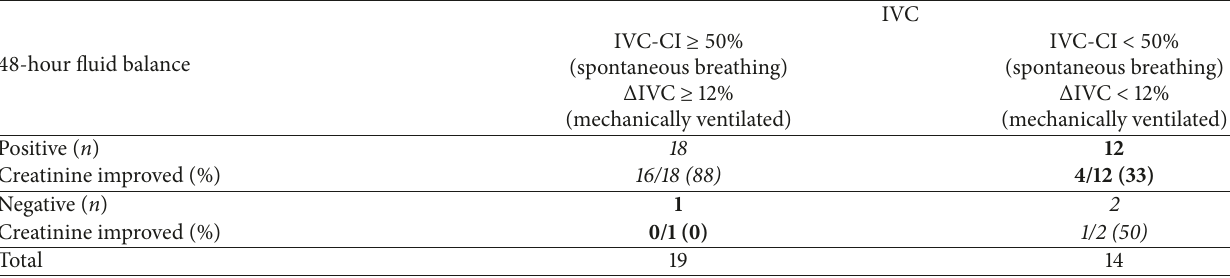
Table 1: Distribution of patients according to their IVC assessment. For each category, group 1 included the patients who were managed in concordance with the ultrasound findings (italic values), while group 2 (bold values) include patients who were not managed in concordance with the ultrasound findings.